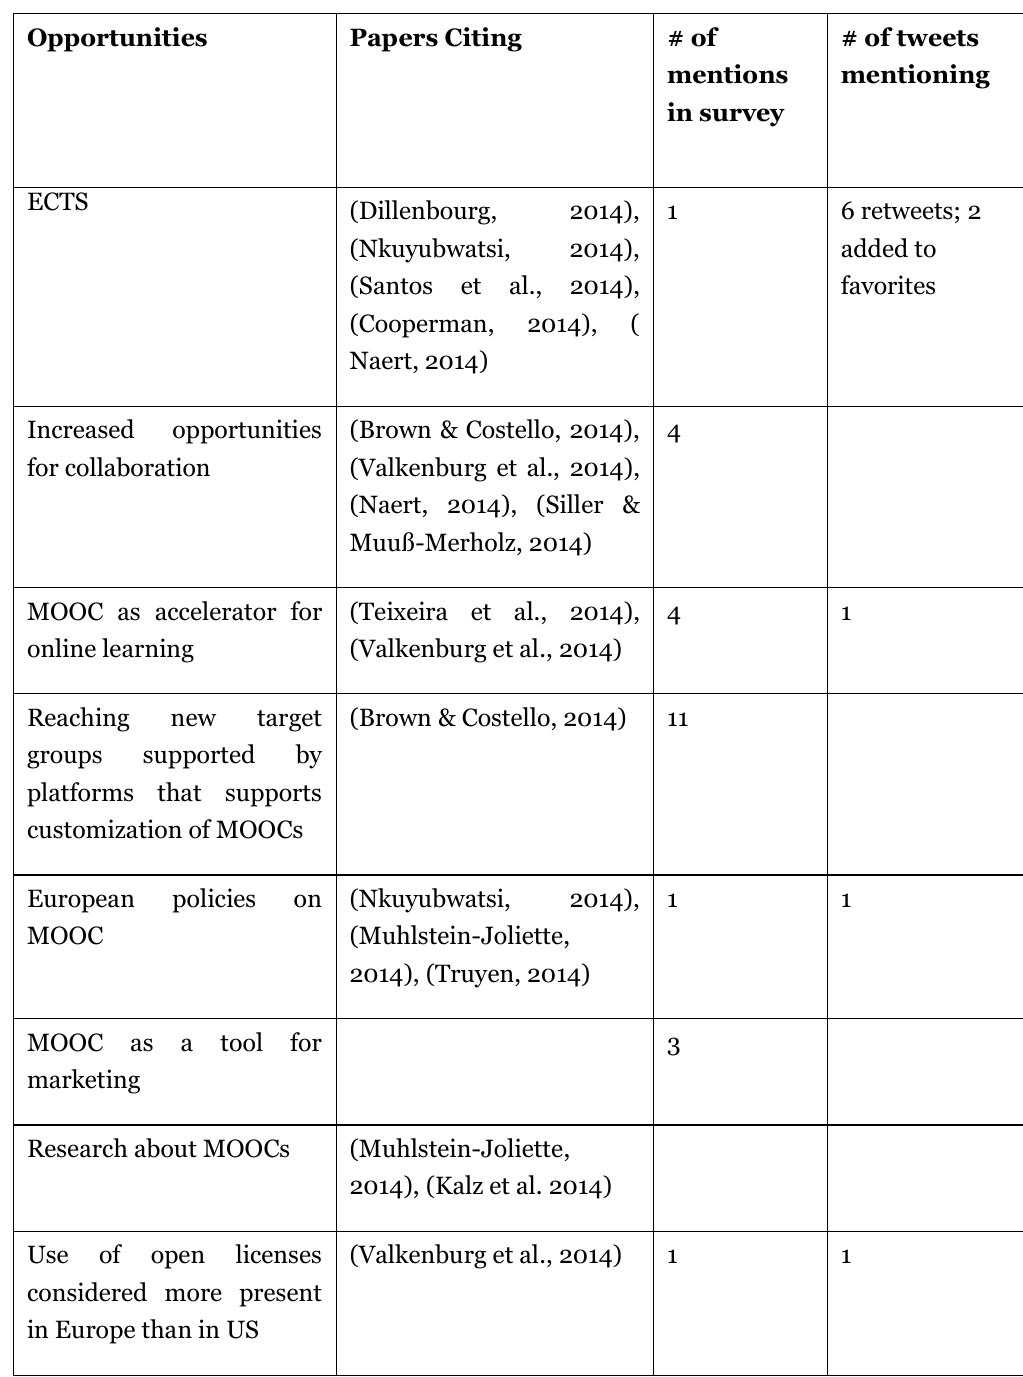
Table 2 Opportunities on Macro Level